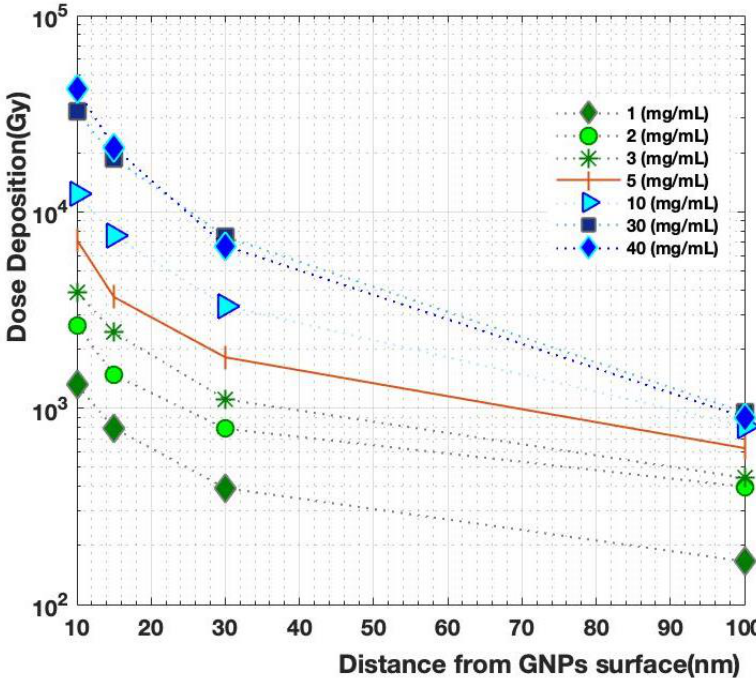
Figure 5. Simulation of the emission of electrons from GNPs with different radii (10, 15, 30, and 100 nm) consisting of water with several GNP cluster concentrations.